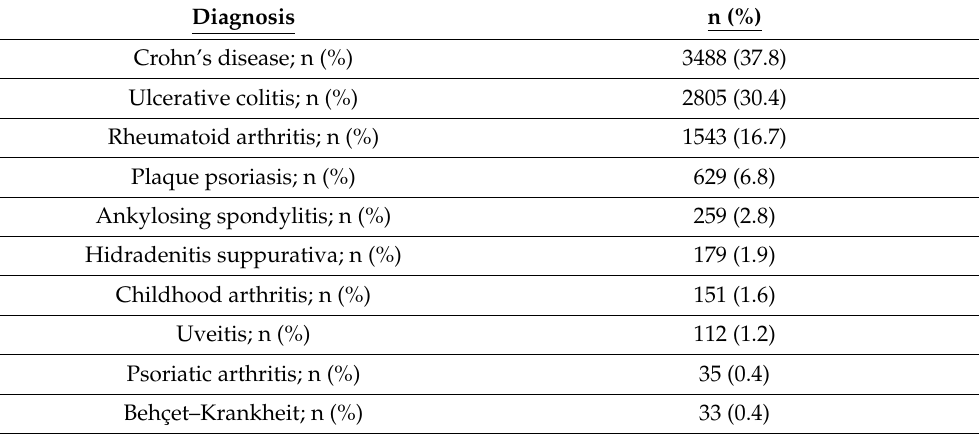
Table 2. Diagnoses of immune-mediated inflammatory diseases in 9234